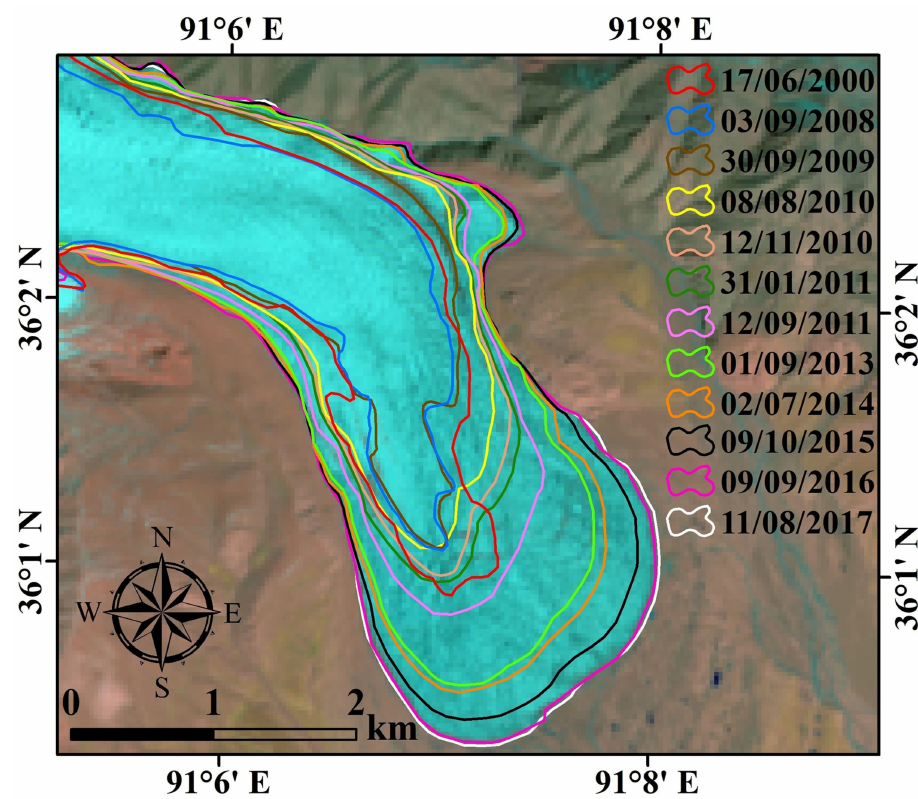
Figure 4. Changes in the boundary of the tongue of the Monomah Glacier from June 2000 to August 2017. Lines in di ff erent colors: glacier boundaries on di ff erent dates; background: false-color Landsat-8 / OLI image acquired on 9 September